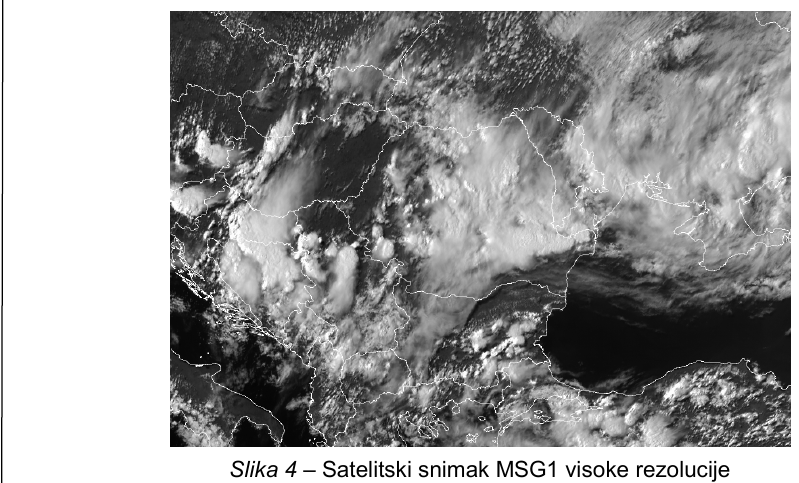
Figure 4 – MSG1 satellite image of high